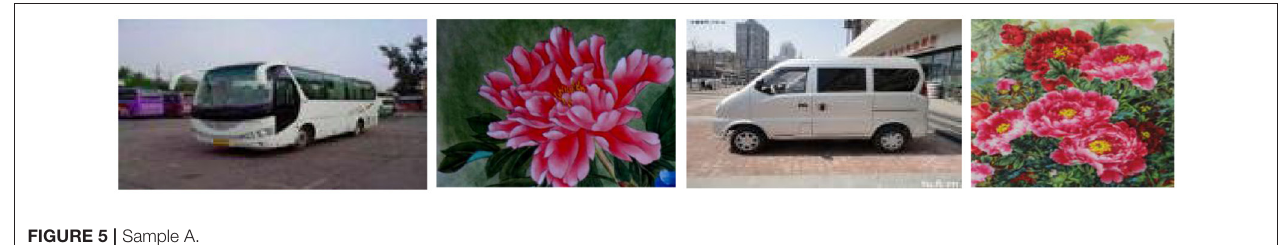
FIGURE 4 | Multi-feature fusion process.